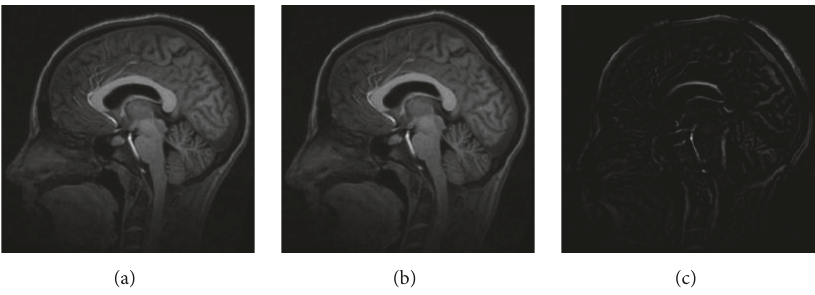
Figure 4: Medical image. (a) Reference image, (b) moving image, and (c) initial difference.